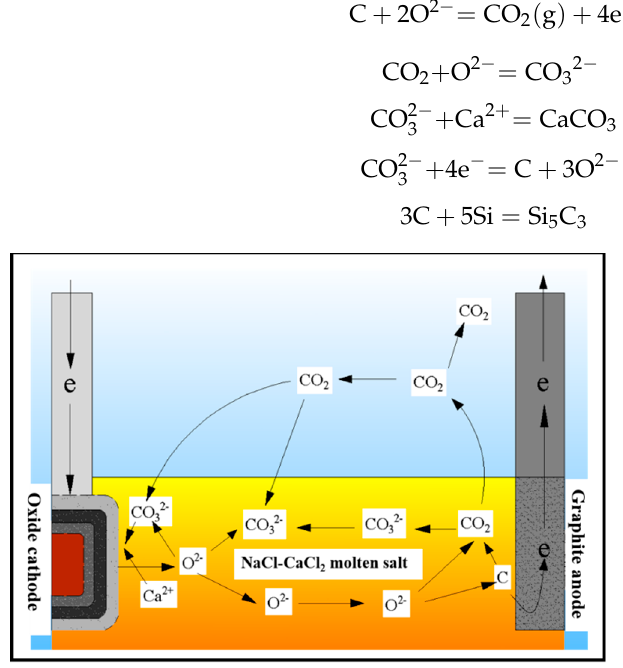
Figure 8. Schematic diagram of C cycle.